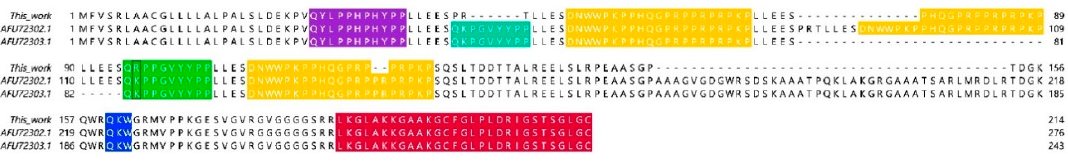
Figure 7. Bradykinin-potentiating peptides (BPP). Comparison of amino acid sequences of A. feae peptides with those of known bradykinin-potentiating peptides (pyroGlu = Z). The number of each consensus letter is represented by a histogram on the top of the figure. Alignment was generated by MUSCLE with percentage identity coloring scheme where the white color is corresponding to 0% identity and the darkest color to 100%. 3.3.9. Biological Activity of New Bradykinin-Potentiating Peptides To study their biological activity, the bradykinin-potentiating peptides Y-BPP and R-BPP were prepared by peptide synthesis and purified by reverse-phase chromatography. The potentiating effect was investigated in vivo in SD rats; arterial blood pressure was registered. Anesthetized rats received peptides through venous catheter, and the arterial catheter was used to record blood pressure (BP). Injection of bradykinin at a dose of 7 µg/kg resulted in the BP drop by 27–33% (Figure 8). Administration of either Y-BPP or R-BPP 10 min later produced a further small decrease (by about 10%) in BP and strongly enhanced the effect of bradykinin injected 5 min after BPP (Figure 8). The potentiating effect was dose-dependent (Figure 9) and was observed for about half an hour at the dose of 300 µg/kg and 1 mg/kg for Y-BPP (Figure 9A,B) and at the dose of 1 mg/kg for R-BPP (Figure 9C,D). No potentiating effect was detected one hour after BPP administration (Figure 9).